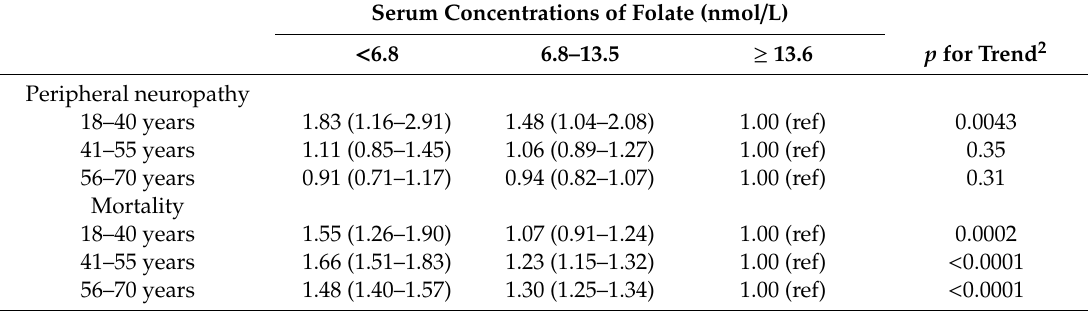
Table 2. Hazard ratios (95% CI (confidence intervals)) of peripheral neuropathy and mortality according to categories of serum folate concentrations and age group. 1